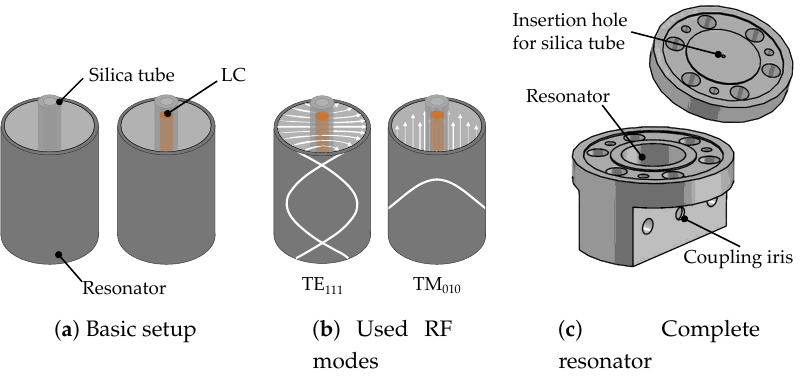
Figure 6. Resonator setup for dual mode LC characterization based on the cavity perturbation technique at 19 GHz.